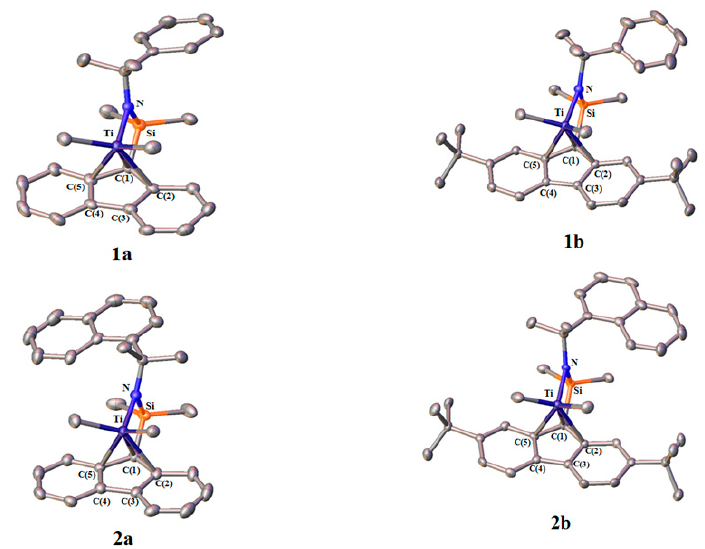
Figure 2. Structure of fluorenylamidotitanium complexes 1a , 1b , 2a , and 2b . Hydrogen atoms are omitted for clarity. Atoms are drawn at the 40% probability level.